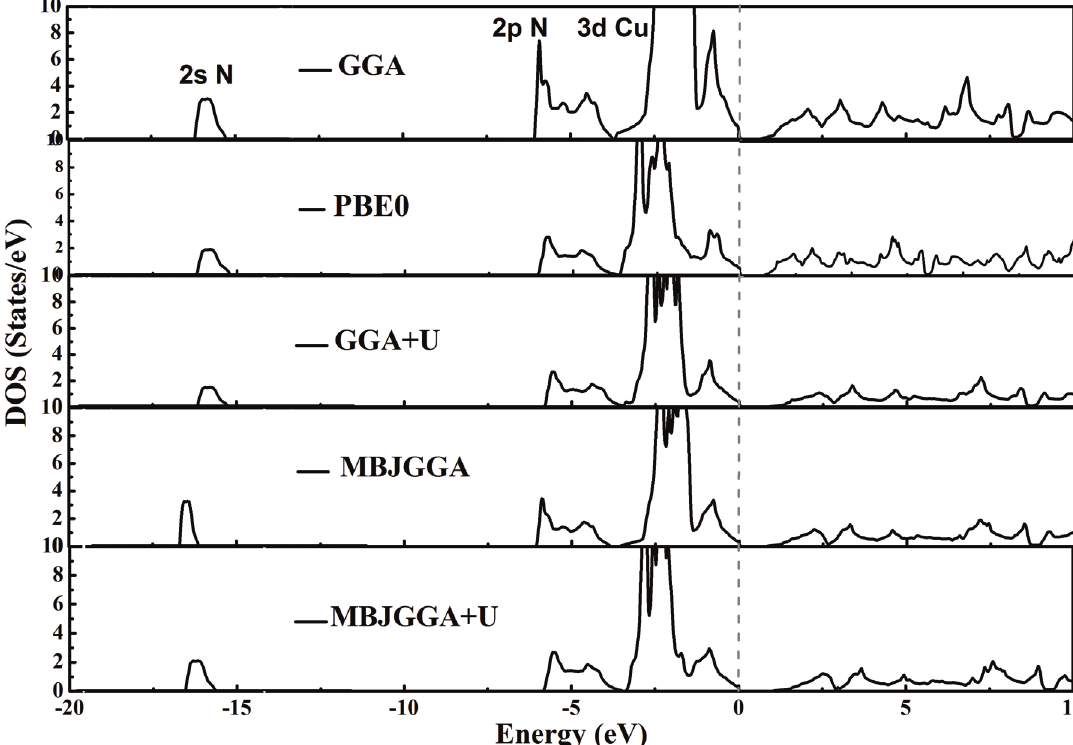
Figure 4. Total and partial density of states of Cu N at the ground state by using GGA, PBE0, GGA+U, MBJ and MBJ+U approximations. 3 Table 2. The calculated bandgap energy and comparison with other results. Other